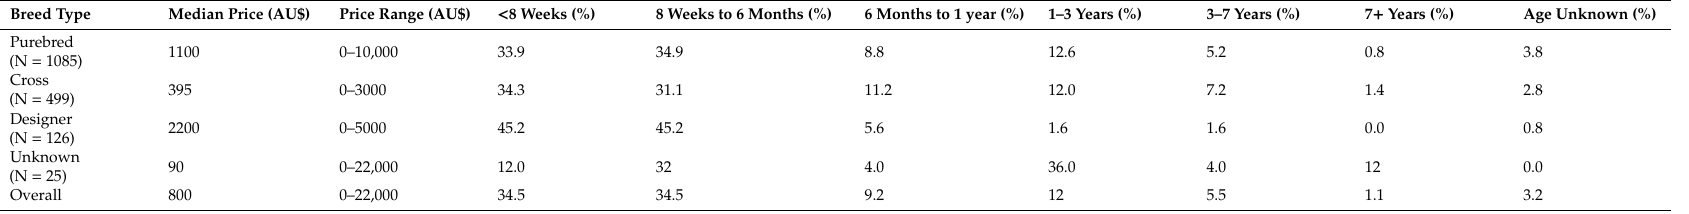
Table 3. Price and age distribution from two individual webscrapes from Gumtree dog and puppy advertisements (25 March and 8 April 2019) in Australia. Total of 1735 unique advertisements, 76 advertisements did not include a price and 56 advertisements did not include age of